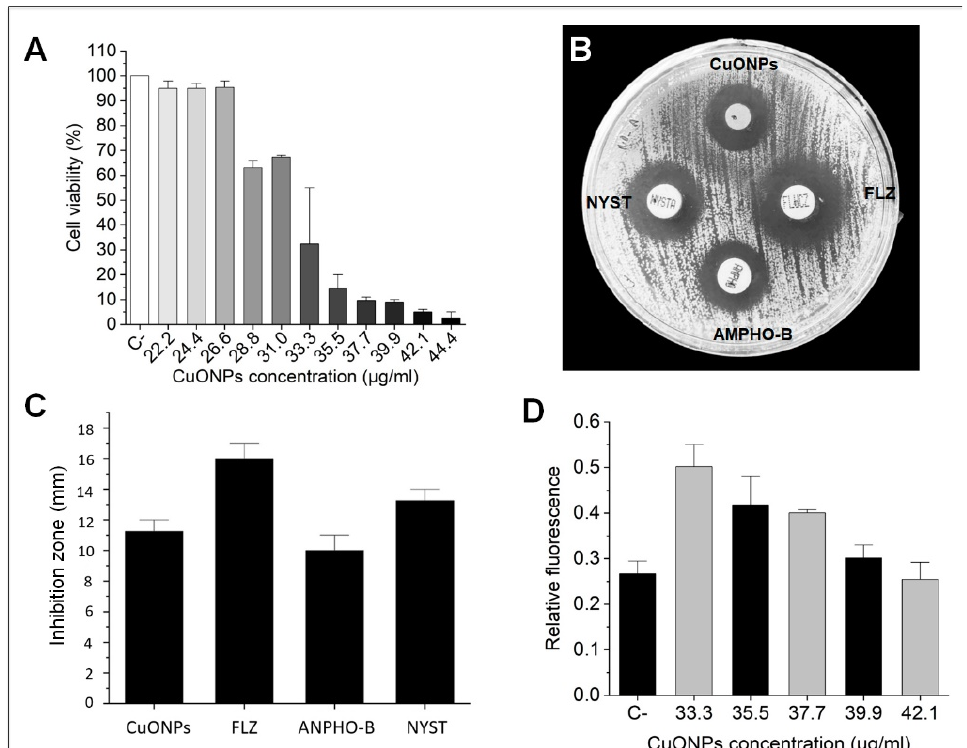
Figure 6. ( A ) Cell viability of C. albicans after 48 h of incubation with CuONPs at different concentrations for MIC determination; ( B ) Inhibition of C. albicans by CuONPs and conventional antifungals; ( C ) Histogram of inhibition zone diameters obtained by the antifungal susceptibility test after 24 h of incubation; ( D ) ROS production by C. albicans after 24 h exposure to CuONPs. C ‐ = negative control; FLZ = Fluconazole; ANPHO ‐ B = Amphotericin B; NYST = Nystatin.